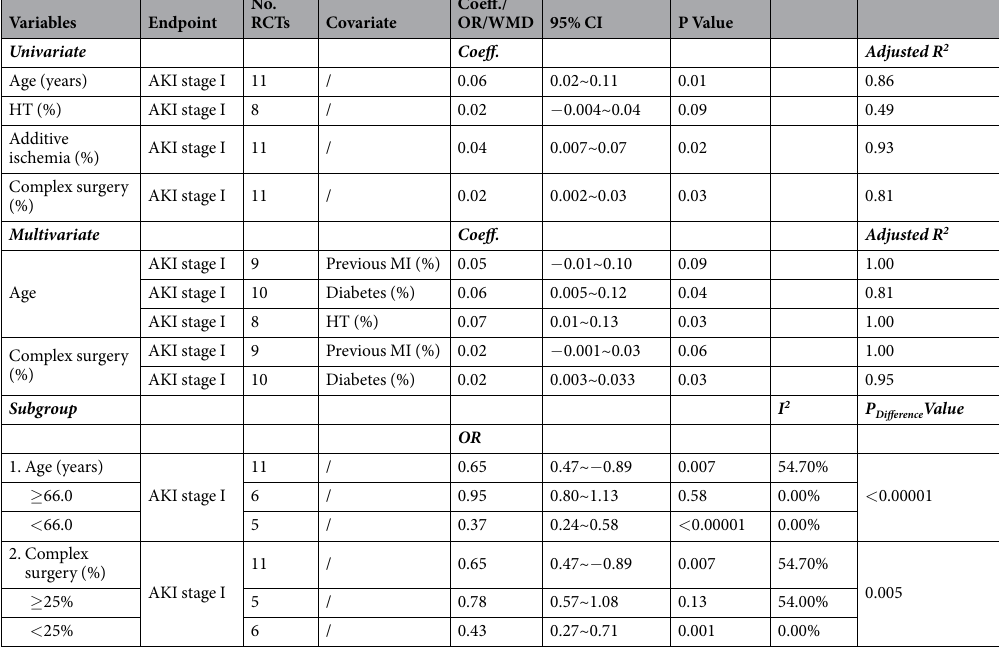
Table 4. Meta-regression and Subgroup analyses for the potential sources of heterogeneity. Note: AKI, acute kidney injury; ICU stay, intensive care unit stay; HT, hypertension; previous MI, previous myocardial